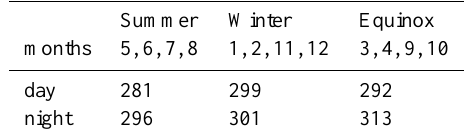
(cid:12) (cid:12) (cid:12) j 50Hz , peak (cid:12) , of magnetic local time for two different threshold values. Table 1. Median of peak current densities, seasons (in µ A / m 2